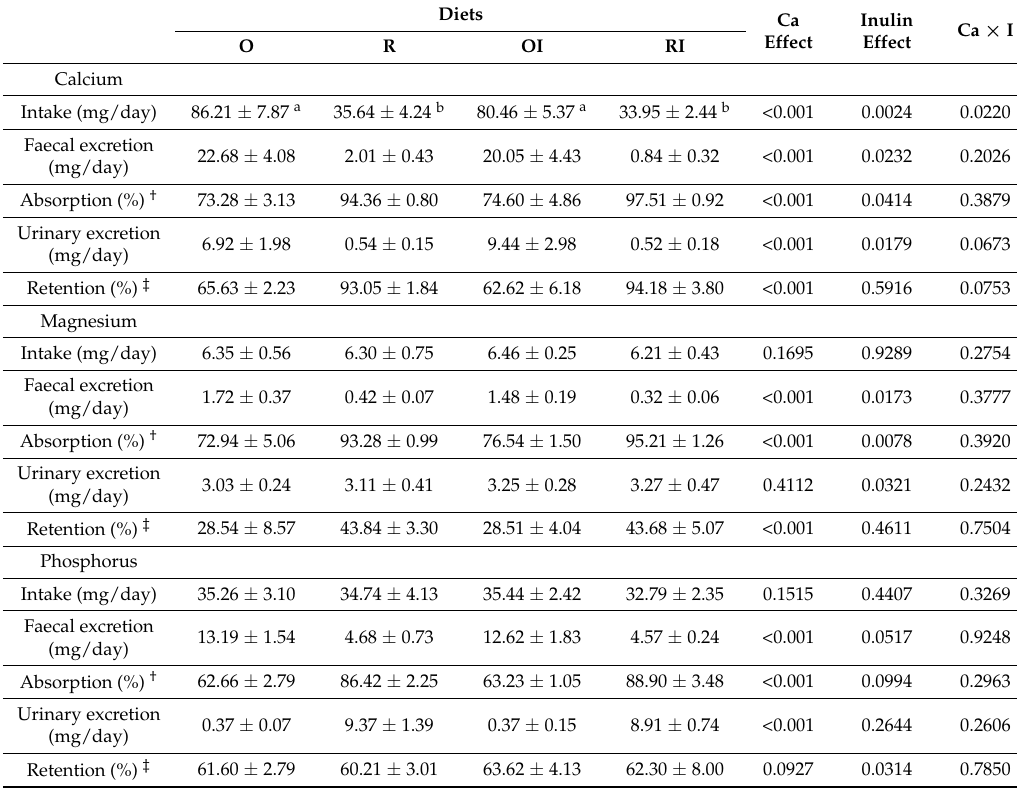
Table 5. Intestinal absorption and retention of calcium, magnesium and phosphorus in rats fed experimental GF diets